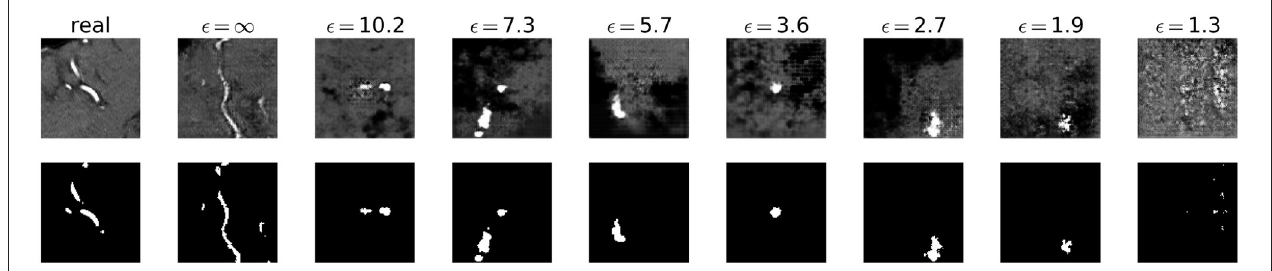
FIGURE 2 | Synthetic TOF-MRA patches (top row) and corresponding segmentation labels (bottom row) with different values of ǫ compared to real patient data (first column). A lower ǫ (i.e., more privacy) leads to more noisy images.